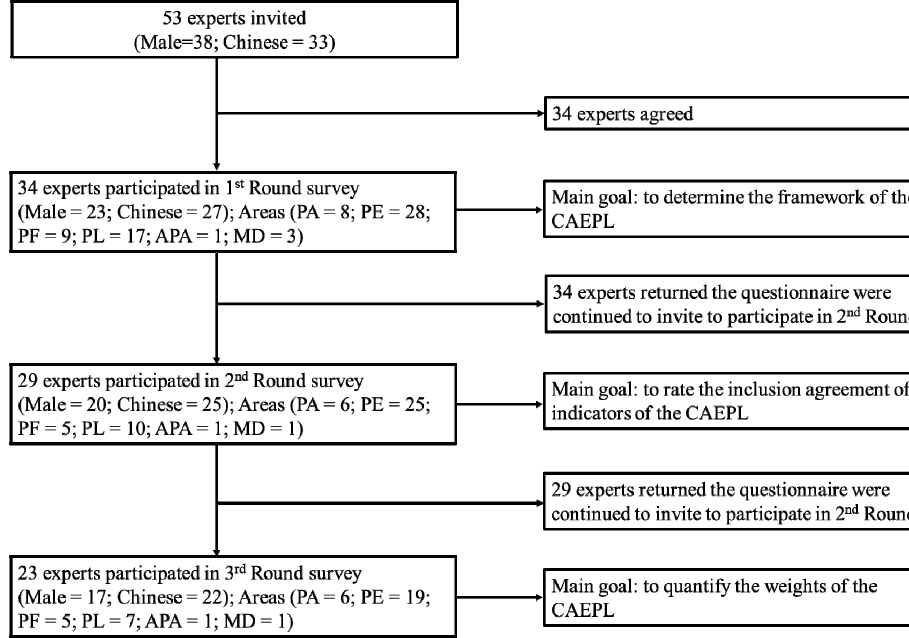
Figure 2. The procedure of Delphi process. PA—physical activity; PE—physical education; PF—physical fitness; PL—physical literacy; APA—adapted physical activity; MD—motor development; CAEPL—Chinese Assessment and Evaluation of Physical